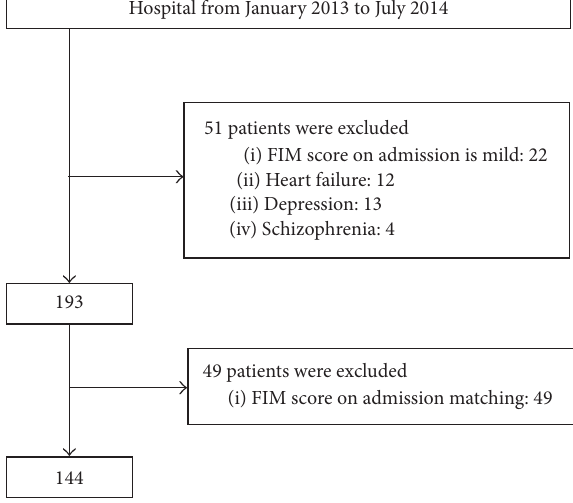
Figure 1: Flow chart of the subject selection process.